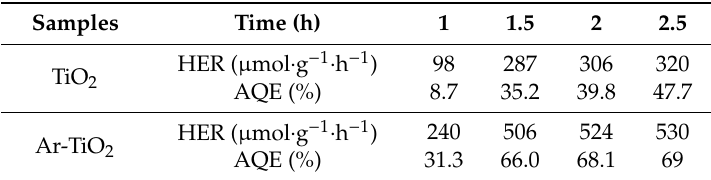
Table 4. Apparent quantum e ffi ciencies (AQE) and H 2 evolution rates (HER) of the TiO 2 and Ar-TiO